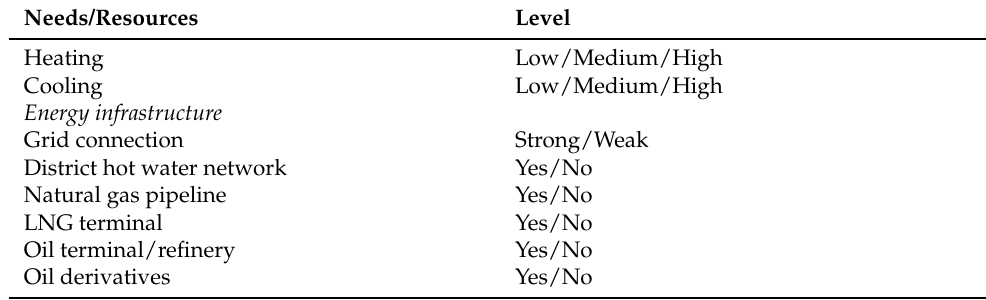
Table 1. Typical RenewIslands